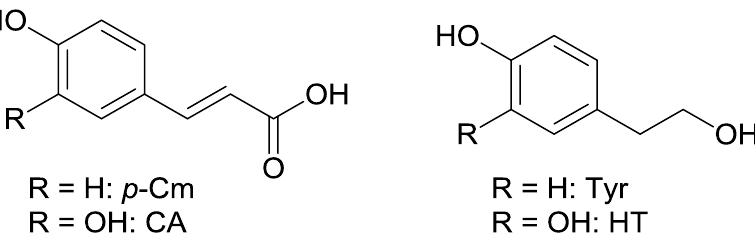
Figure 1. Chemical structures of the selected olive phenols. In hydroxytyrosol-glucosides (HT-Glc), the Glc unit can be attached to any of the three OH groups of HT.